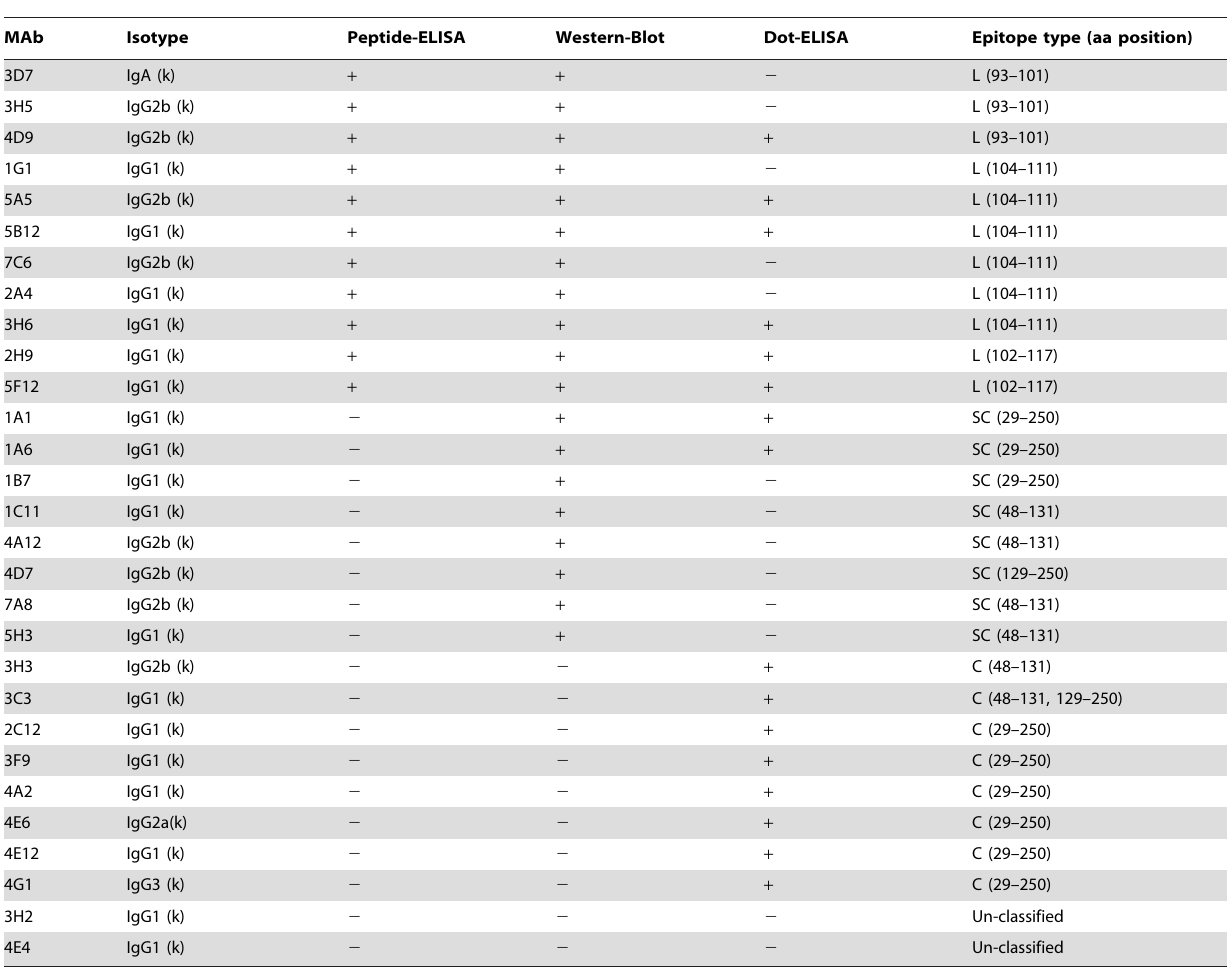
Table 2. Classification of mAbs reactive to the epitopes of native BP26.